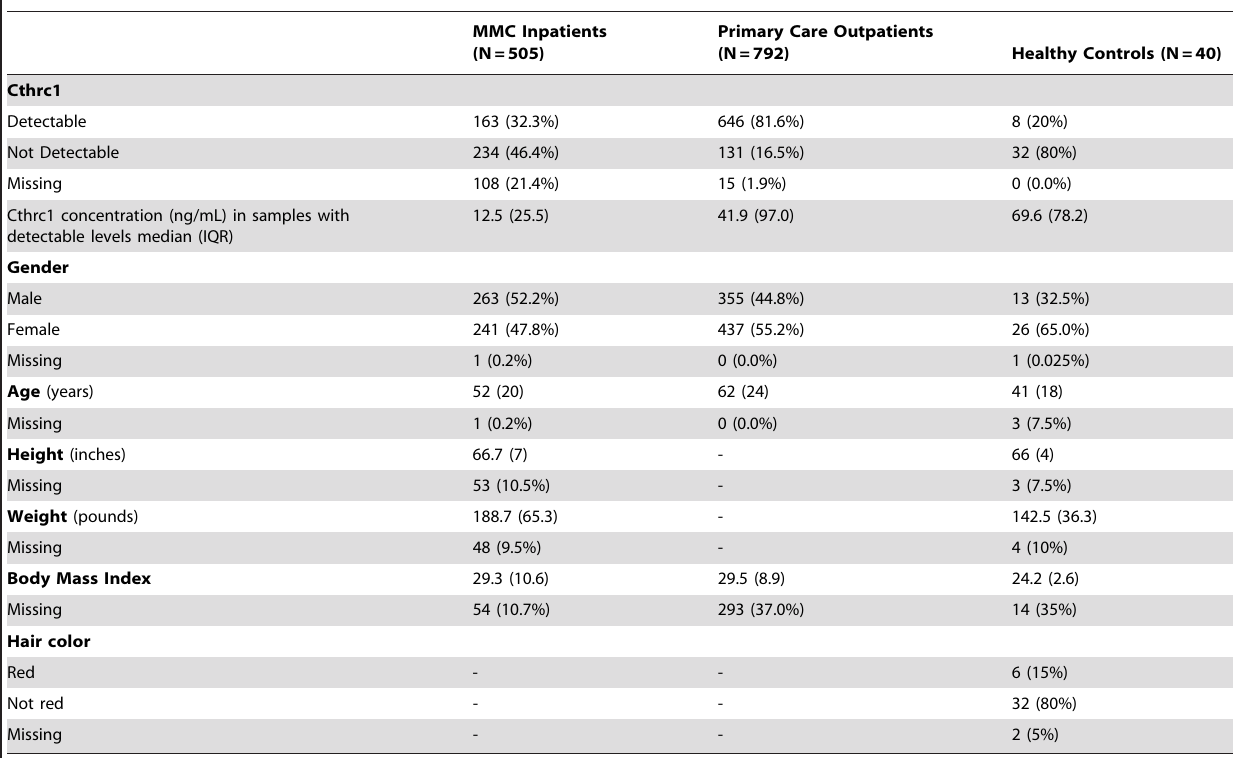
Table 1. Basic characteristics of the patient population used in this